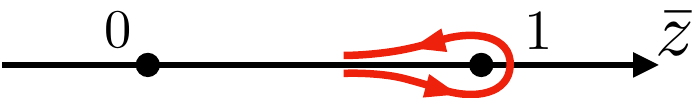
Figure 8. The analytic continuation about ¯ z = 1 , denoted by G ( z, ¯ z (cid:9) ) , used in the Lorentzian inversion formula. G ( z, ¯ z (cid:8) ) denotes the analytic continuation in the opposite